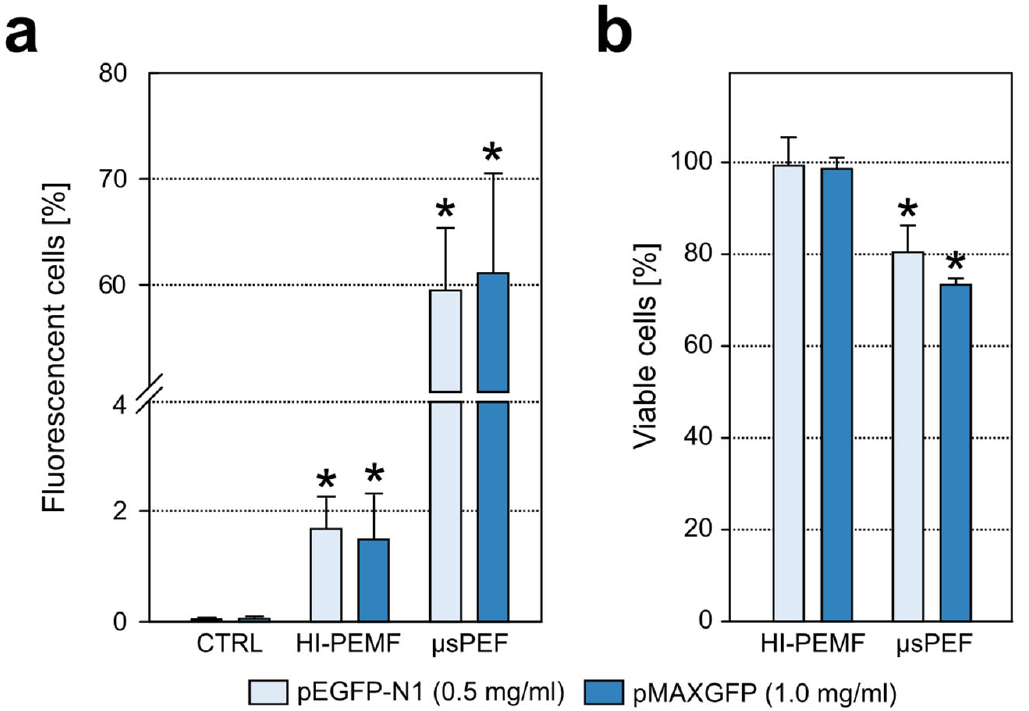
Figure 2. Gene electrotransfection efficiency ( a ) and cell viability ( b ) after the application of HI-PEMF and µ sPEF for pEGFP-N1 (0.5 mg/mL) and pMAXGFP (1.0 mg/mL). Asterisk (*) denotes statistical difference between treated sample and its corresponding untreated sample ( p < 0.05). Mean ± st. deviation is shown for each treatment.